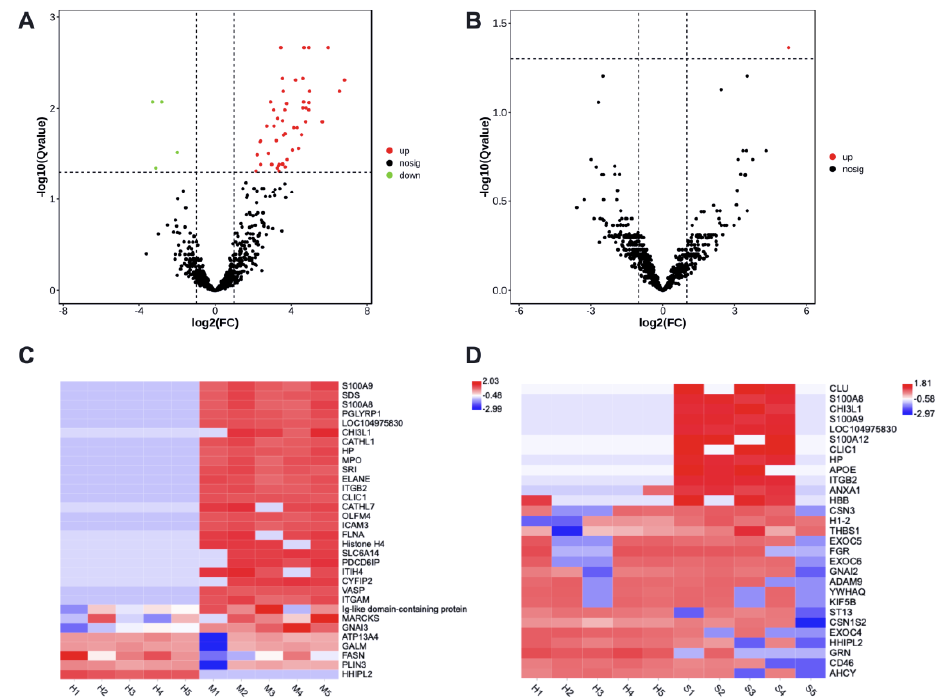
Figure 3. The enrichment of proteins in milk-derived EVs between CM and Healthy group ( A , C ), SM and Healthy group ( B , D ). Volcano plots show significant proteins with a Q value < 0.05. Heatmaps display the abundance distribution of selected proteins in Tables 1 and 2; the color key indicates the normalized LFQ intensity per protein. Healthy, healthy cows, n = 5; M, subclinical mastitic cows, n = 5; S, subclinical mastitic cows, n = 5. Some proteins were only present in one or two samples and could not represent the overall group. Protein H1 histone (A7MAZ5), present in less than three samples in each group, was excluded. Protein was defined as specific only if at least present in three of the five samples and absent in another group. Finally, there were 32 proteins specific to the CM or Healthy group (Table 1) and 29 proteins specific to the SM or Healthy group (Table 2).